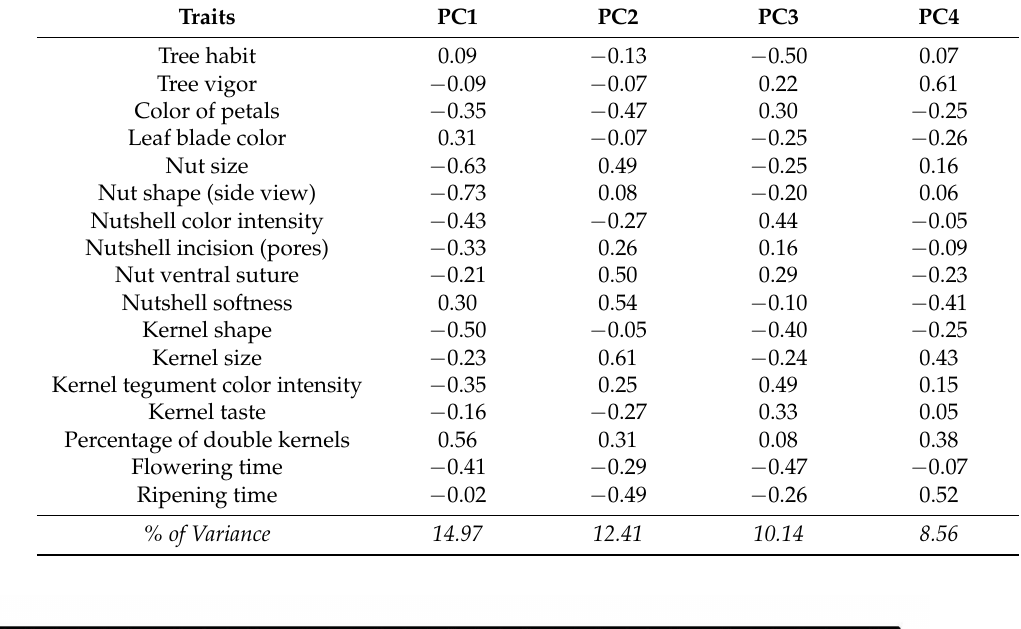
Table 4. Eigenvalues and proportion of total variability for the first eight principal components from PCA analysis of the almond genotypes studied.